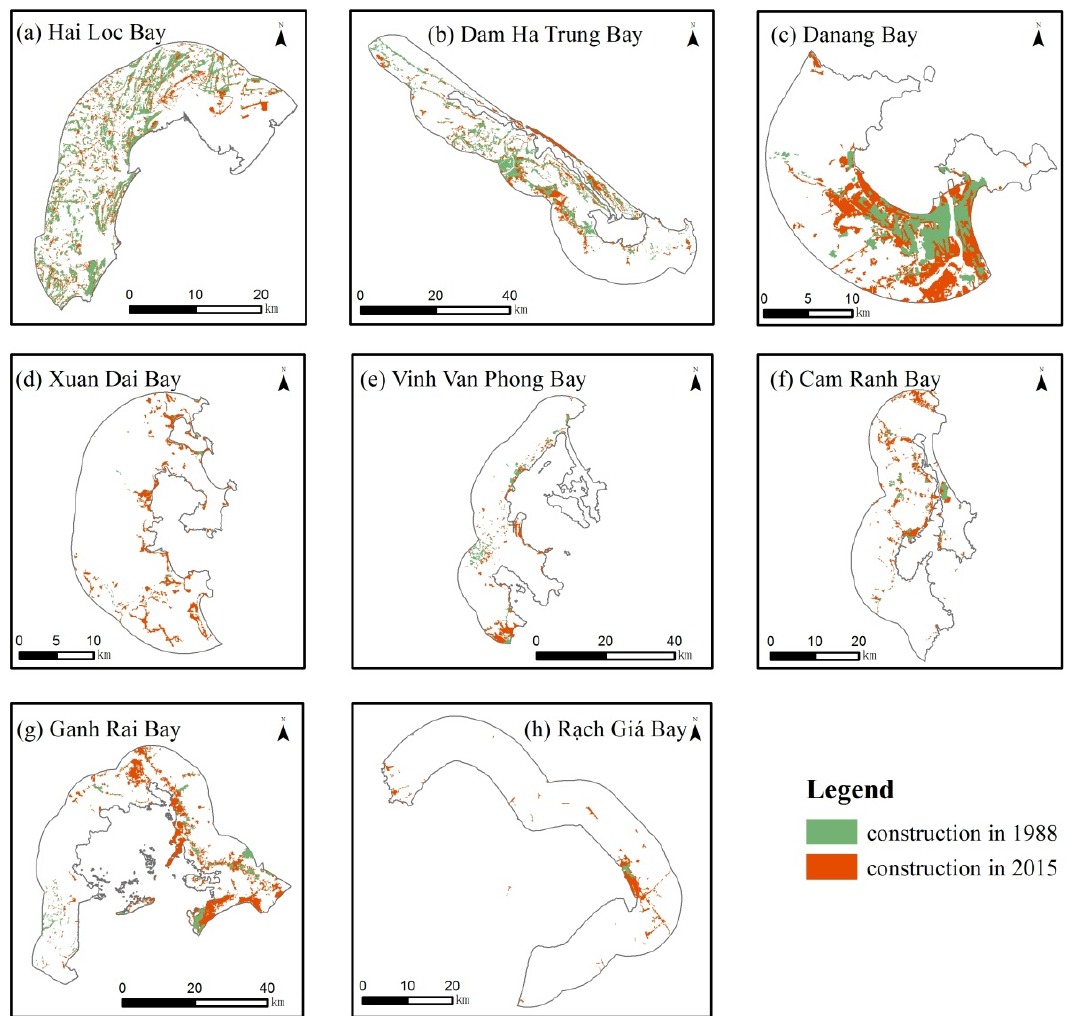
Figure 5. Spatial distribution of construction land in bays. ( a ) Hai Loc Bay; ( b ) Dam Ha Trung Bay; ( c ) Danang Bay; ( d ) Xuan Dai Bay; ( e ) Vinh Van Phong Bay; ( f ) Cam Ranh Bay; ( g ) Ganh Rai Bay; ( h ) R ạ ch Giá Bay.